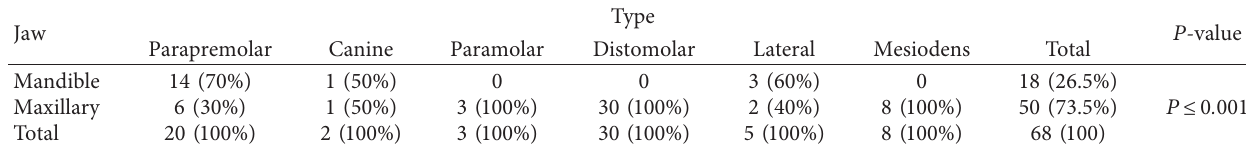
Table 5: Comparison of the type of supernumerary teeth by